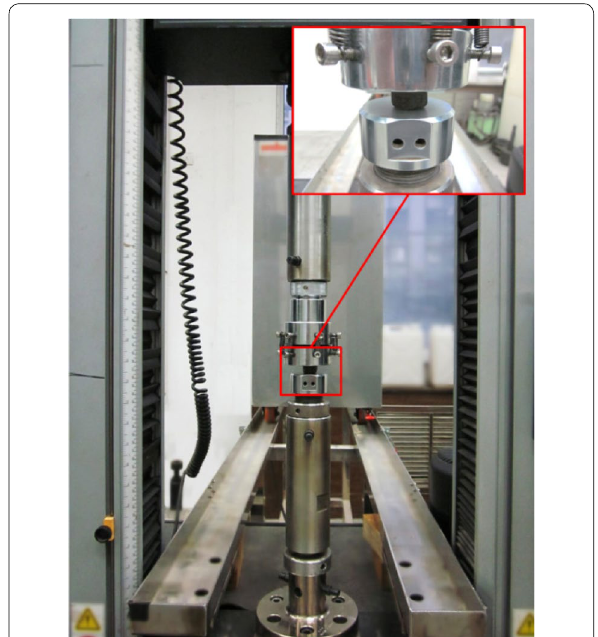
Figure 1 Uniaxial compression tests with rubber